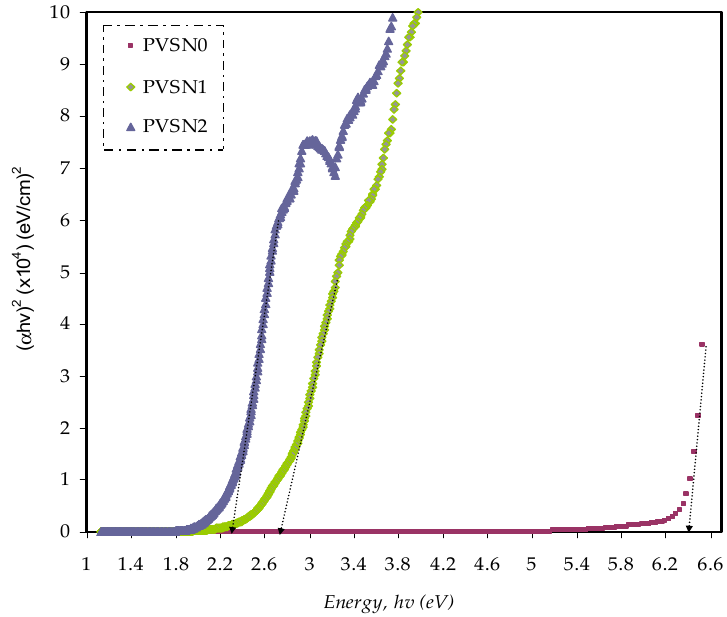
Figure 12. Plot of ( α h υ ) 2 vs. h υ for pure PVA and PC films.